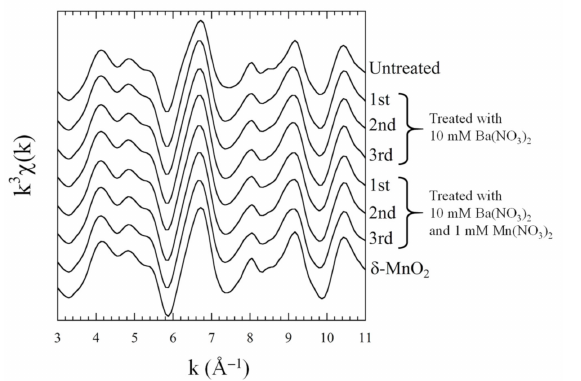
Figure 3. Mn K-edge extended X-ray absorption fine structure spectra for the newly formed biogenic Mn oxides (BMOs) treated with and without 10 mM Ba(NO 3 ) 2 and 1 mM Mn(NO 3 ) 2 . δ -MnO 2 was plotted as a reference phyllomanganate for